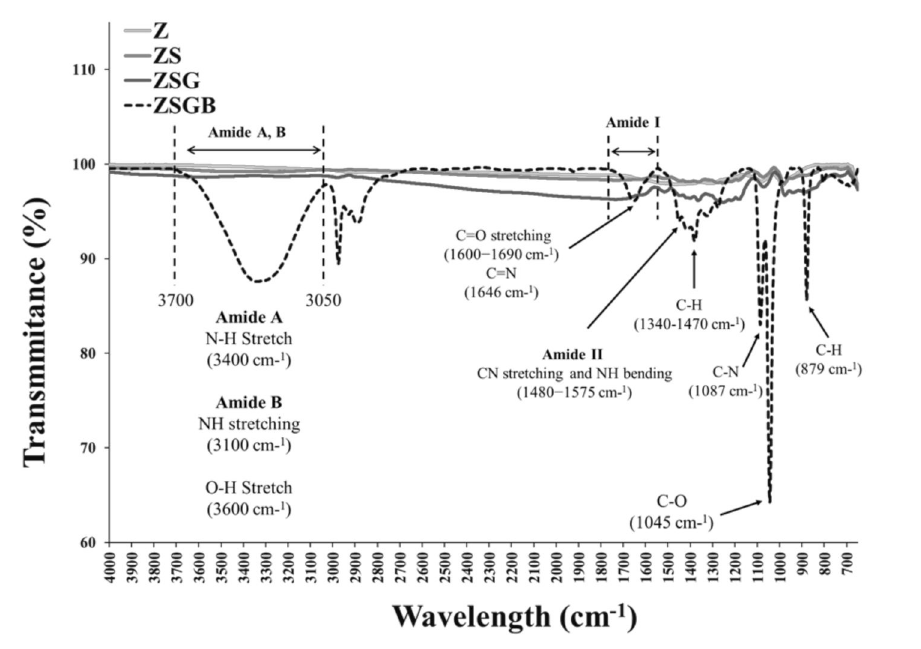
Figure 3. FTIR analysis results showing the function groups of test